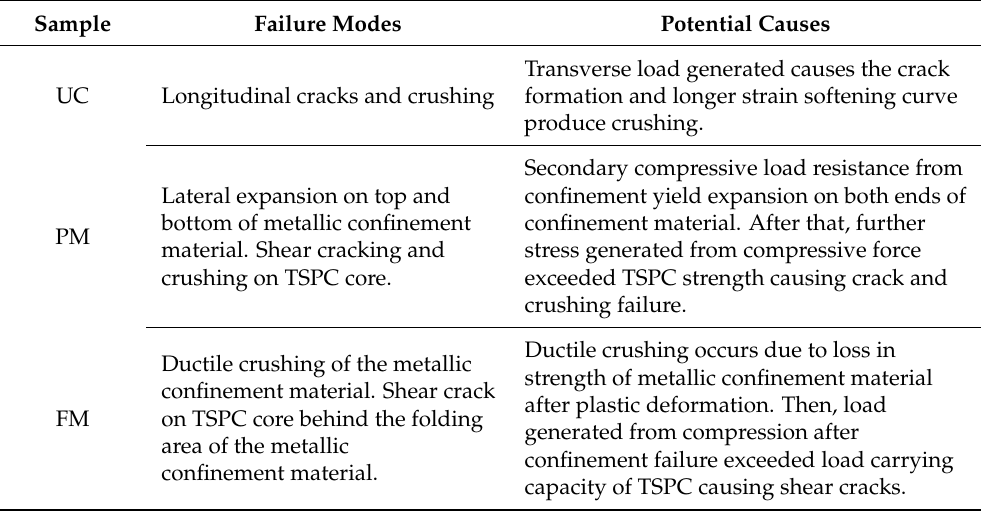
Table 4. Summary of failure modes on all test